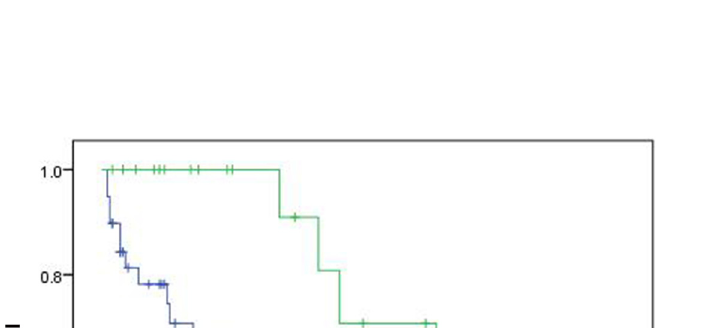
Fig 1. Overall survival curves for patients with SAA and NSAA